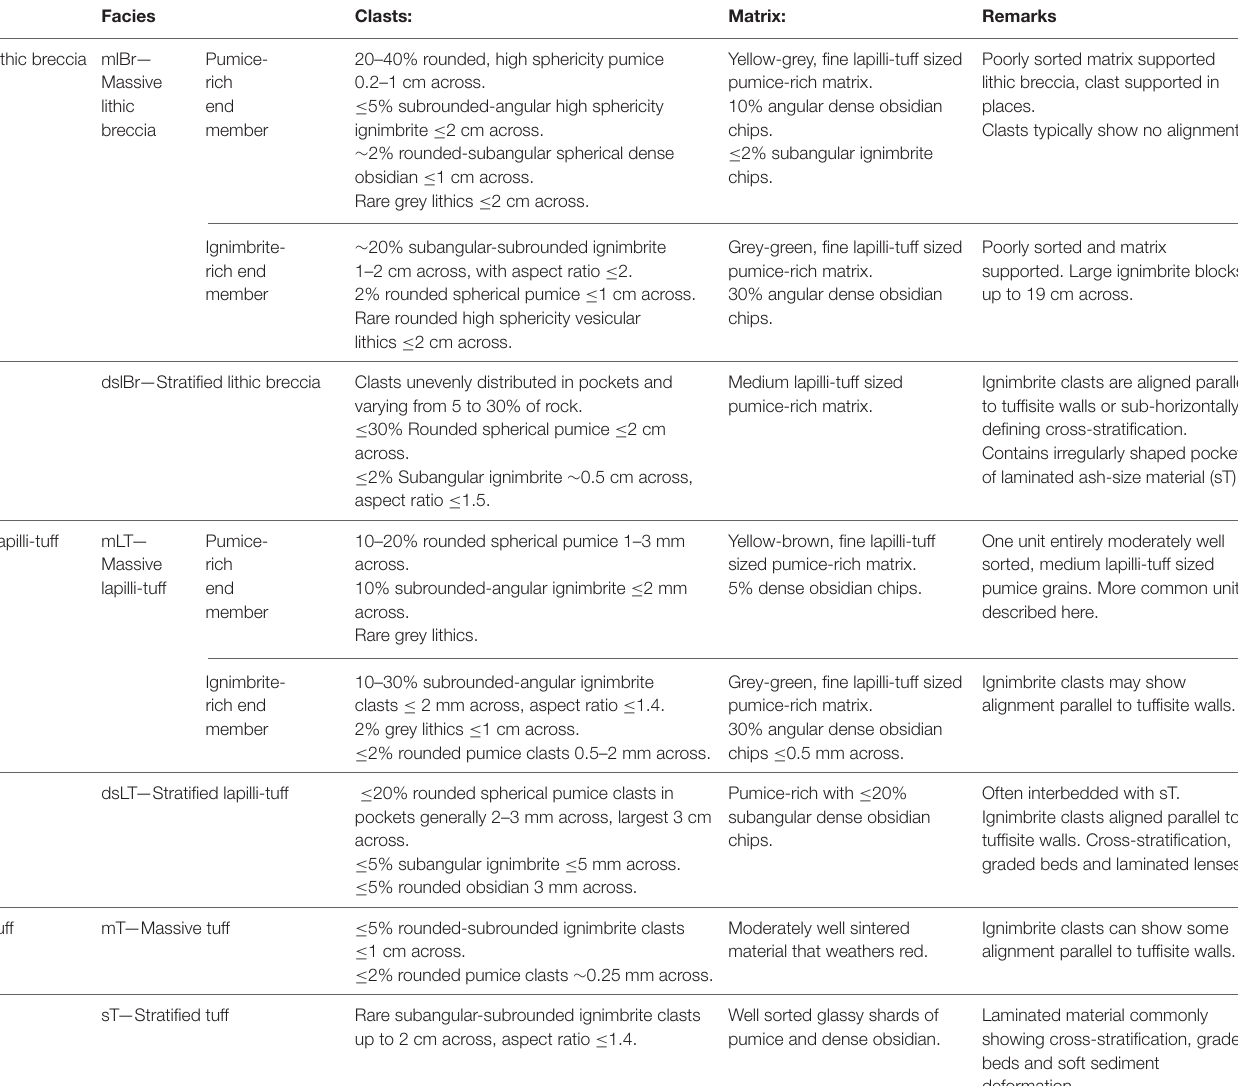
TABLE 1 | Summary of the different tuffisite facies and their